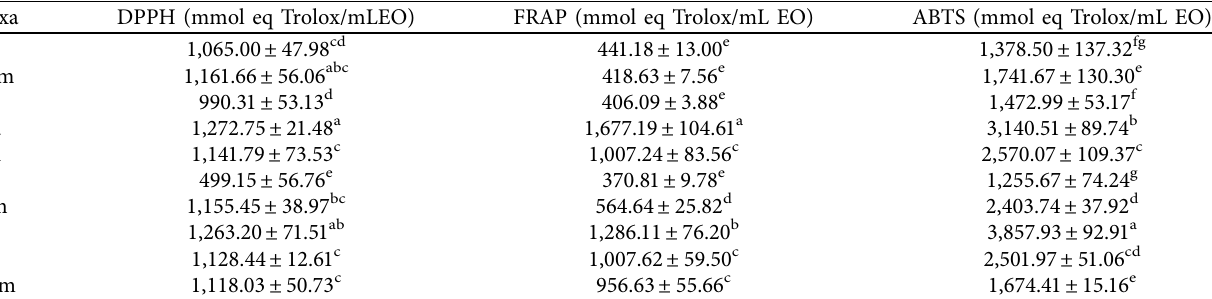
Table 3: Antioxidant capacity of tested essential oils.